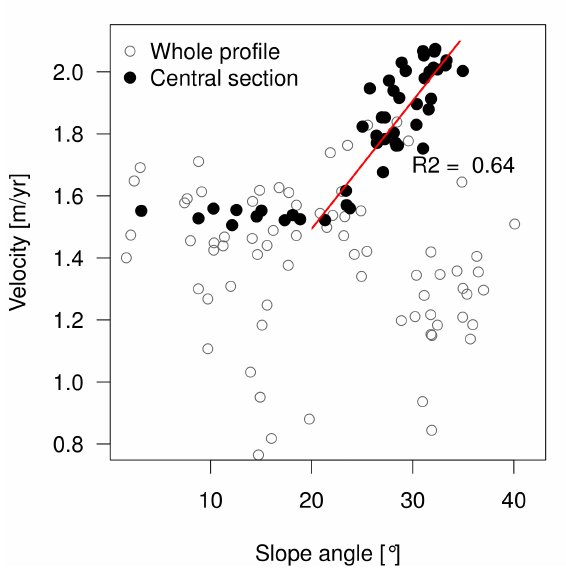
Figure 8. Velocity against slope along the longitudinal profile (circle), with values for the central section (horizontal distance between 50 and 150 m; black dot). The red line is the regression fitted to the values for the central section for a slope angle above 20 ◦